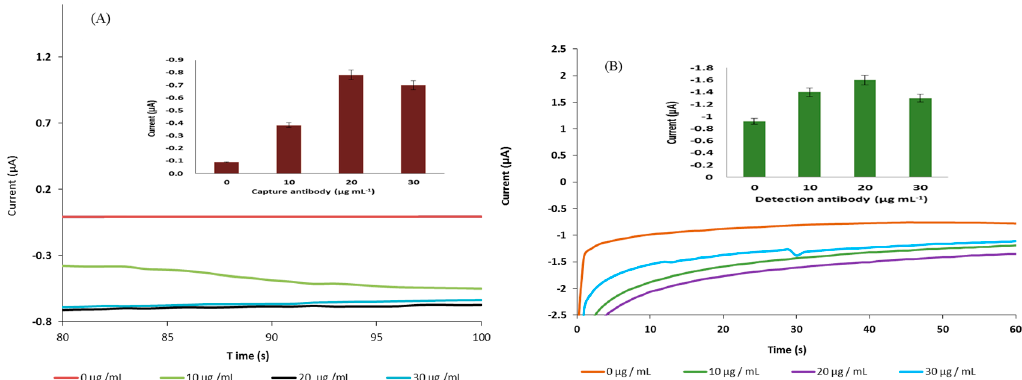
Figure 4. Chronoamperometric response of ( A ) different concentrations of capture antibody on the sensor’s surface in a sandwich assay format; ( B ) different concentrations of detection-horseradish peroxidase (HRP) antibody in a sandwich assay format, n = 3.